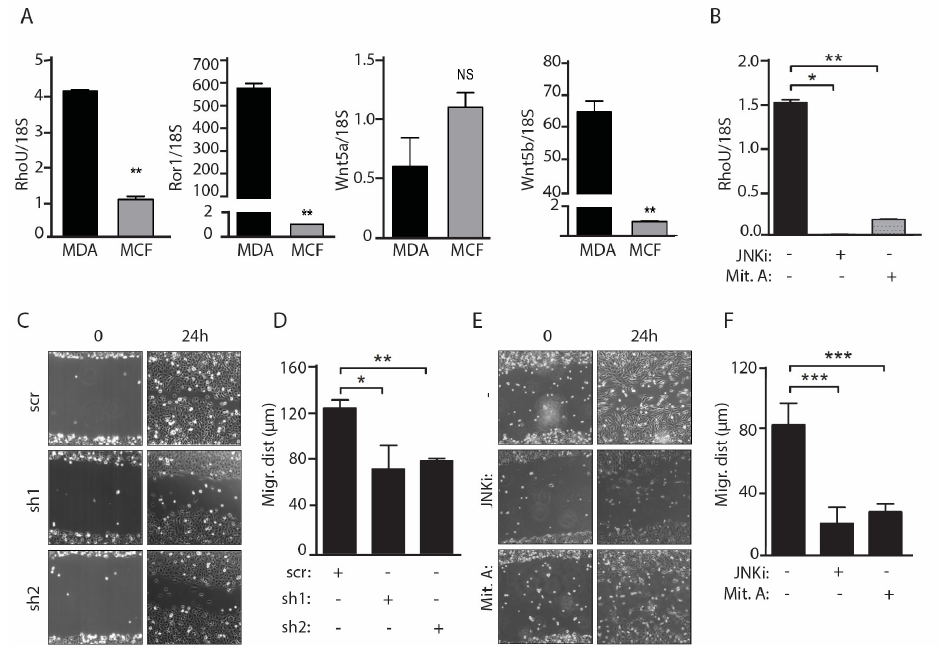
Figure 3. Both RHOU expression and JNK and SP1 activities are required for migration of MDA-MB-231 cells. ( A ) qRT-PCR analysis of RHOU, Ror1, Wnt5a and Wnt5b mRNAs in MDA-MB-231 and MCF-7 cells. ( B ) RHOU mRNA downregulation in MDA-MB-231 cells treated with the JNK or SP1 inhibitors (JNKi, Mit. A). Data are mean ± SEM of the relative expression levels, normalized to 18S rRNA. ( C – F ) Wound healing assays. MDA-MB-231 cells were infected with lentiviral vectors expressing two distinct RHOU shRNAs or a scrambled control (sh1, sh2, scr) ( C , D ), or treated with the JNK or SP1 inhibitors (JNKi, Mit.A) ( E , F ), and migration was assessed by in vitro wound healing